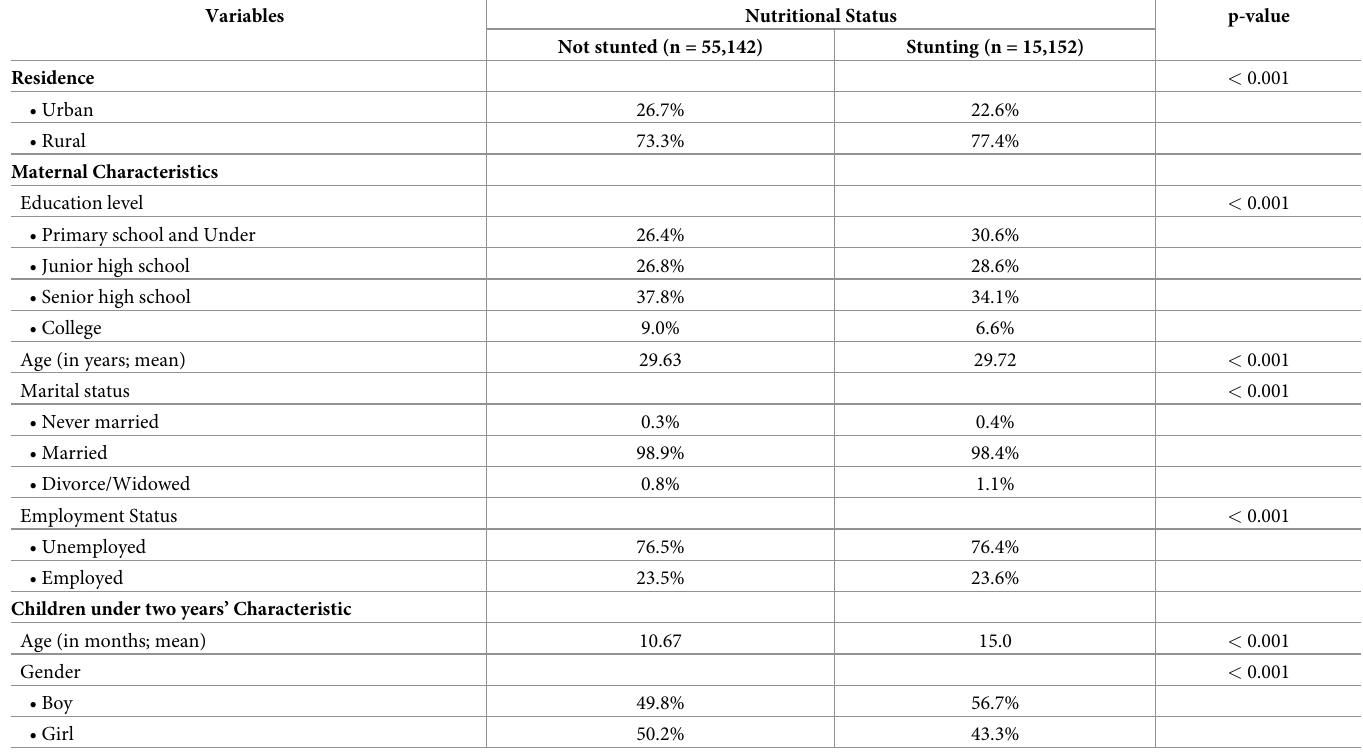
Table 2. Descriptive statistic of nutritional status of children under two years in Indonesia (n =